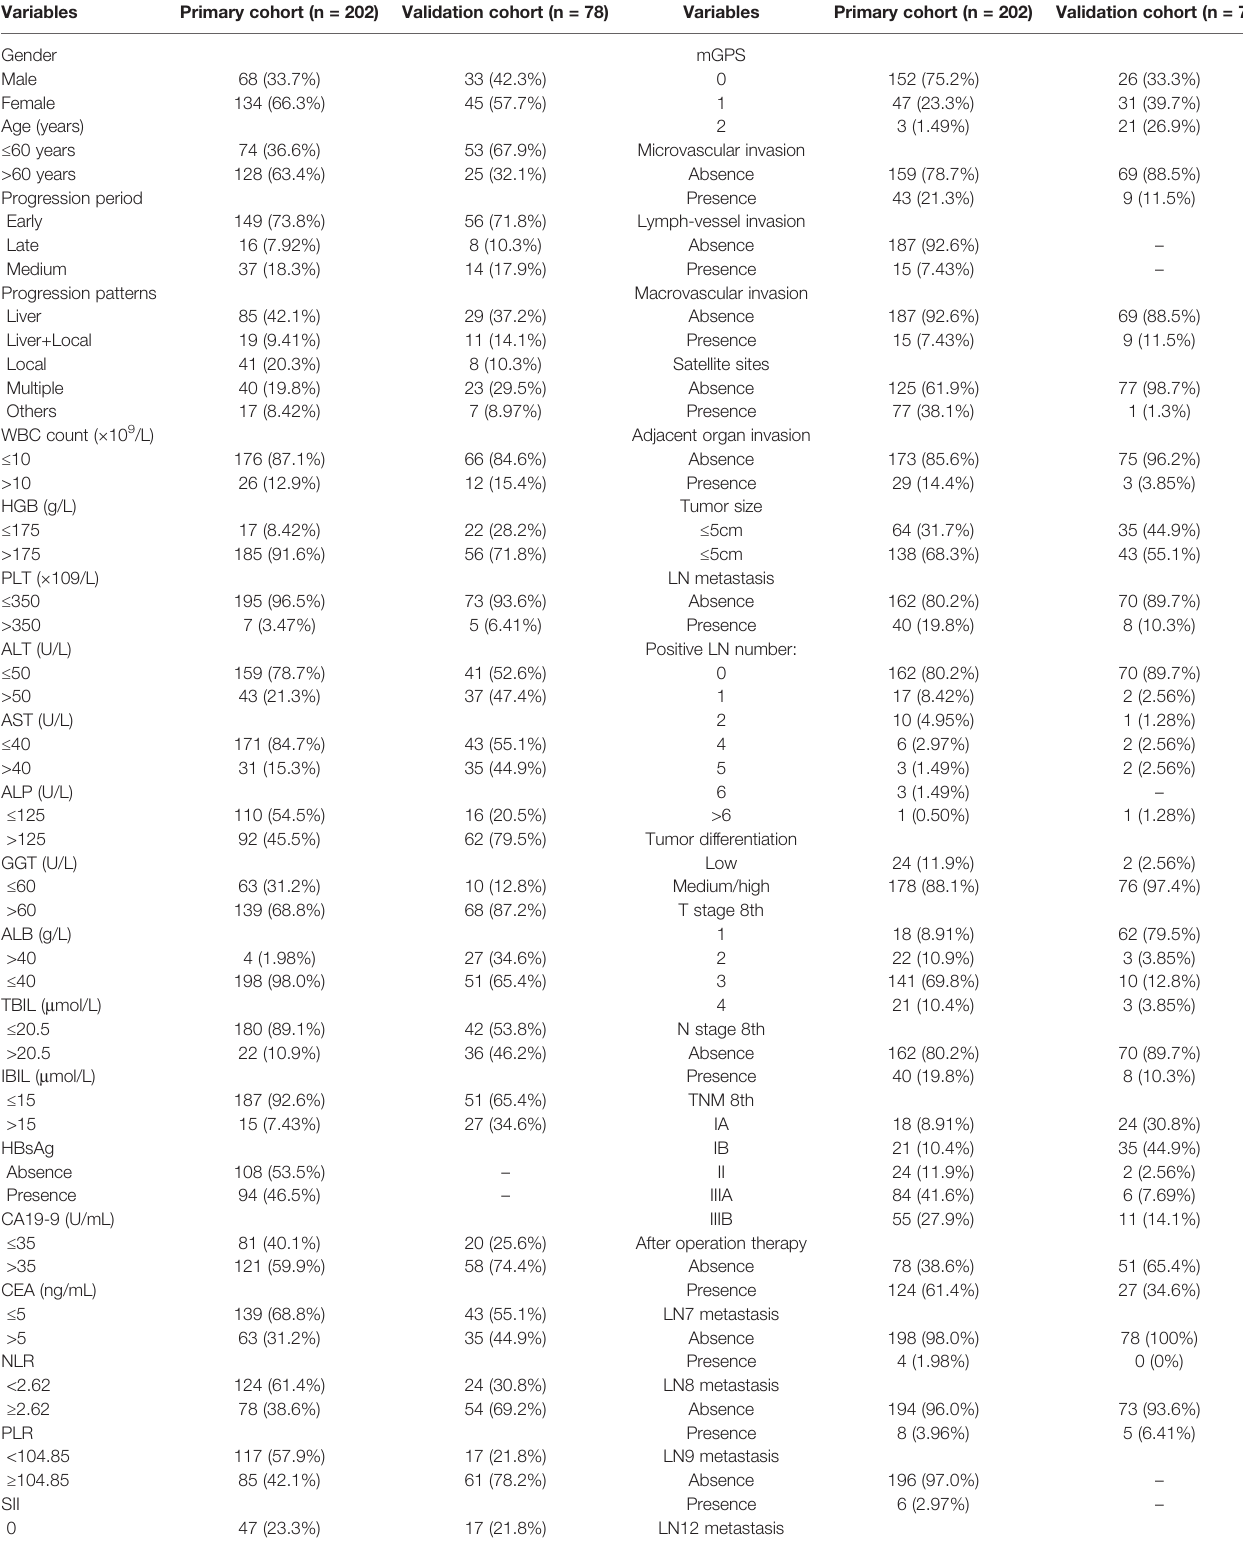
TABLE 1 | Clinical and pathological characteristics of recurred iCCA patients in the primary cohort (SYSUCC cohort) and validation cohort (FHDMU cohort).